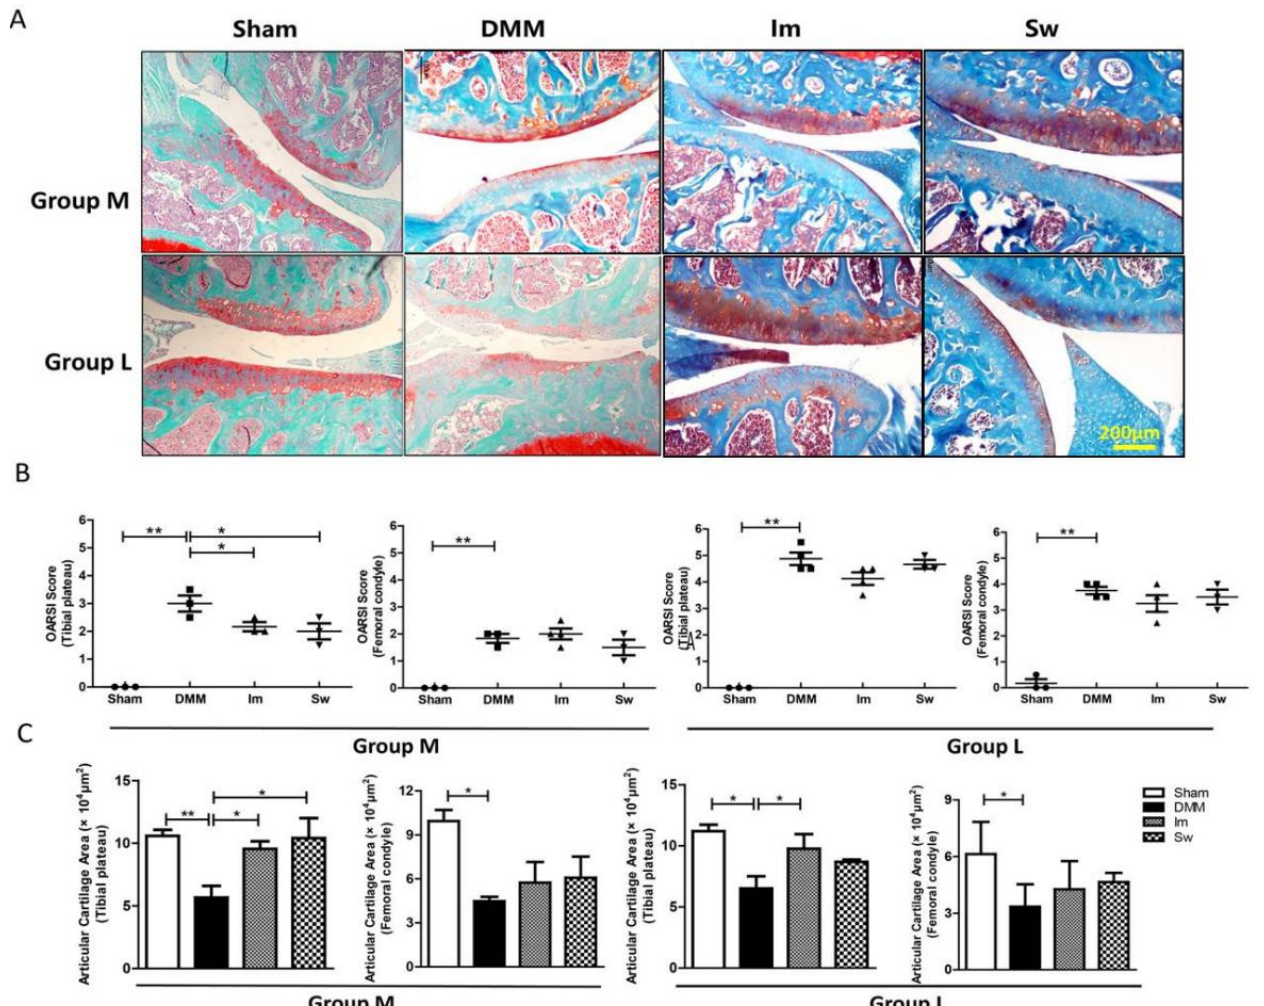
Figure 4. Safranin-O/Fast Green staining showing that immobilization and swimming both play positive roles in the cartilage area and OARSI score, mainly at the middle stage. ( A ) Safranin-O/Fast Green staining of the cartilage (red) and subchondral bone (green). ( B ) DMM significantly increased the OARSI score at both the tibial plateau and femoral condyle after 8 and 12 weeks of DMM. Immobilization and swimming both decreased the OARSI score at the tibial plateau in Group M but not Group L. ( C ) Immobilization rescued the decrease in articular cartilage area at tibial plateau in both groups after 8 and 12 weeks of DMM, whereas swimming only increased the area at tibial plateau in Group M. Group M: middle stage of OA, 4 weeks after DMM and Group L: late stage of OA, 8 weeks after DMM. Im, immobilization; Sw, swim; DMM, destabilization of the medial meniscus; * p < 0.05, ** p < 0.01, n ≥ 3; bar = 200 µ m.